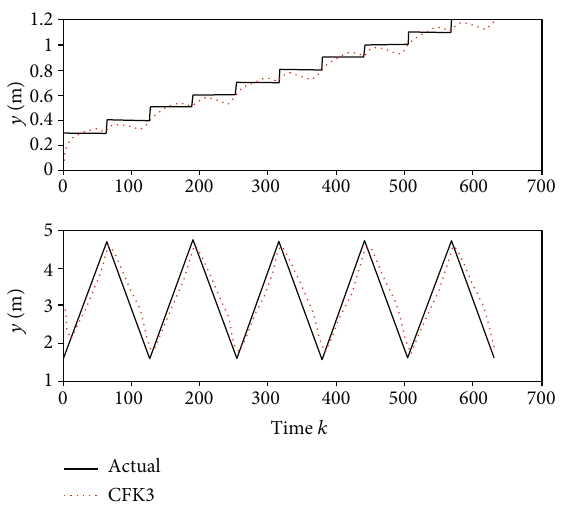
Figure 5: State estimation results after multistep feedback predictive control. Table 3: Comparison of actual and state estimates.